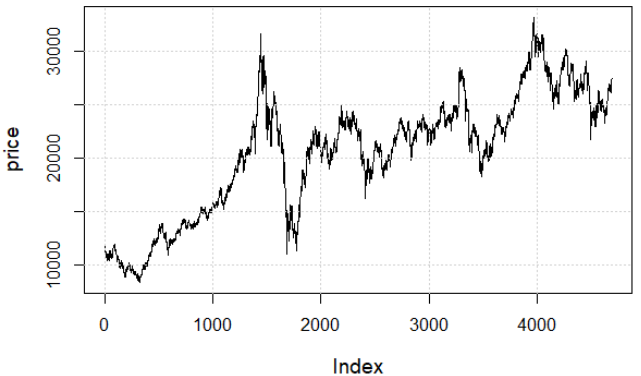
Figure 1. The price of Hong Kong Hang Seng Index (HSI), January 2002–December 2020.